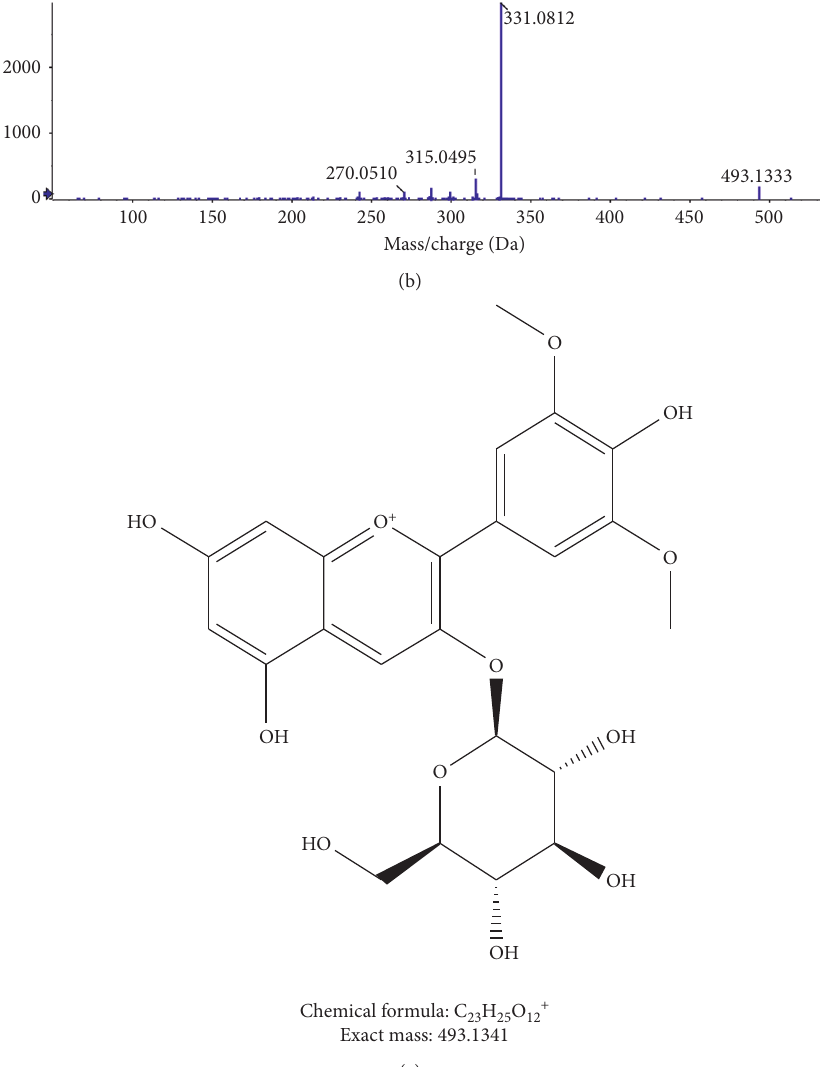
Figure 8: The first class two-level mass spectrogram and the possible structure formula of component